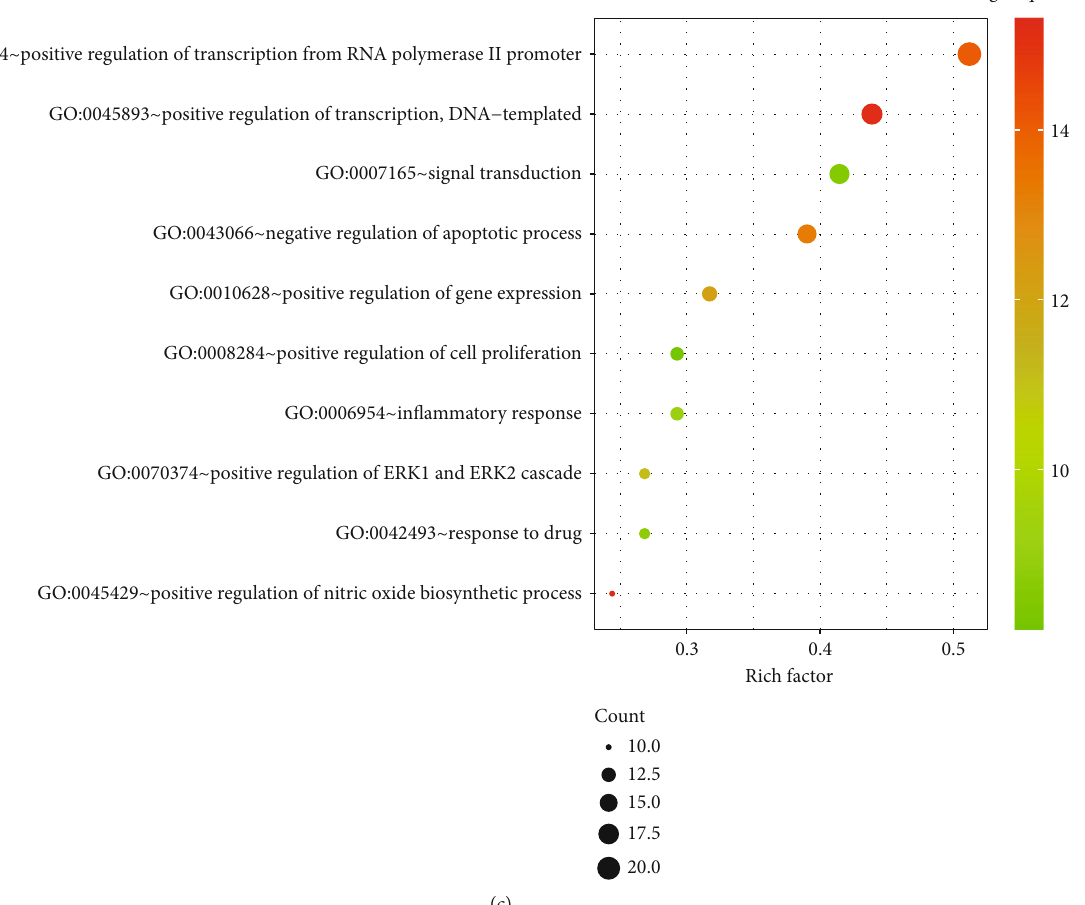
Figure 5: GO enrichment analysis bubble diagram: (a) molecular function; (b) cellular component; (c) biological